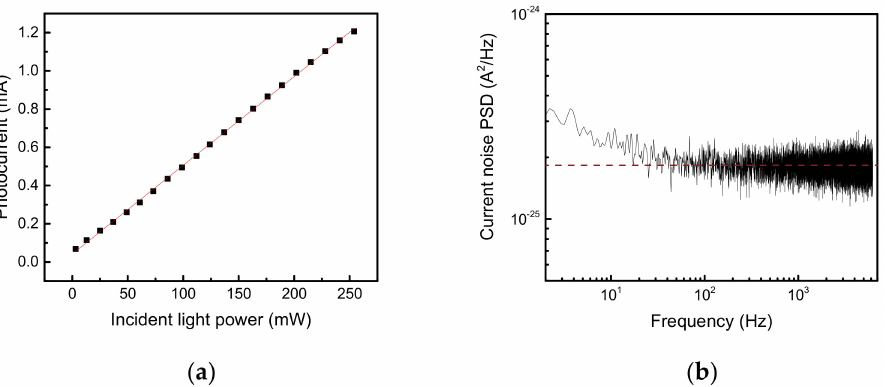
Figure 2. ( a ) Measured photocurrent vs. incident light power of the 2220-cm − 1 distributed-feedback quantum cascade (QC) laser. The measured results are plotted as square black dots, and the red line is a linear fit. ( b ) Current noise power spectrum density of the QC detector at room temperature (no cooling). The red dashed line indicates the Johnson–Nyquist noise level calculated from 4 k B T / R , where k B is Boltzmann’s constant, T is the device temperature, and R is the device